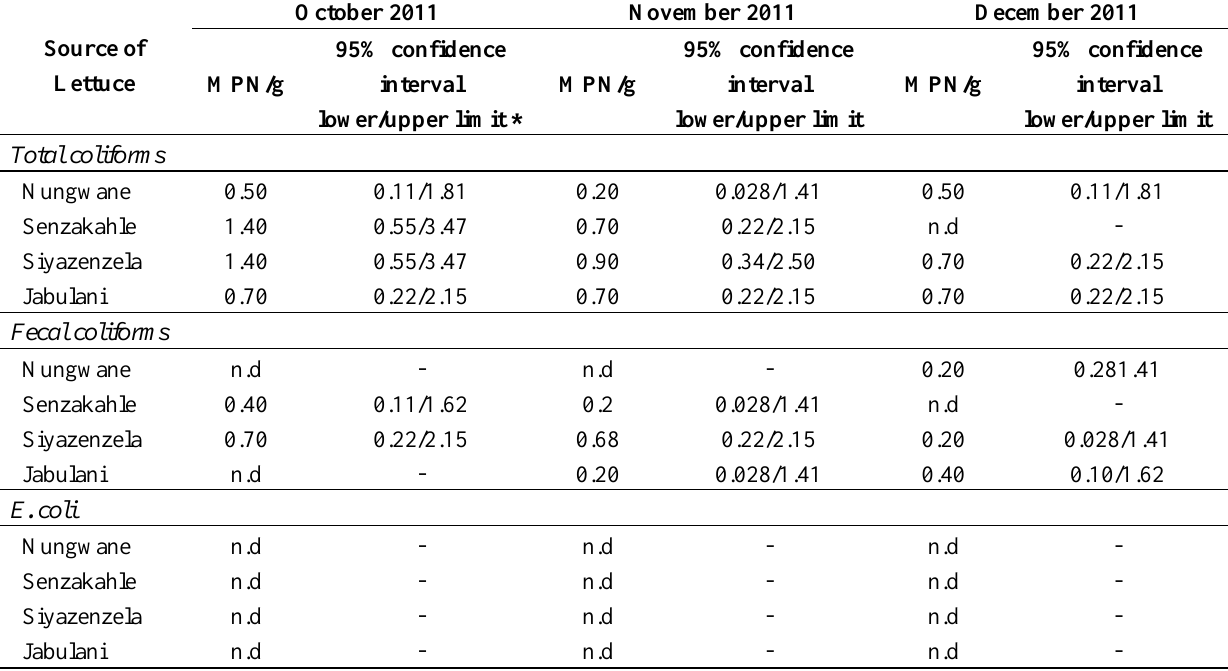
Table 7. MPN per g of lettuce for total and fecal coliforms as well as E. coli produced by different farmer cooperatives for the months of October, November, and December